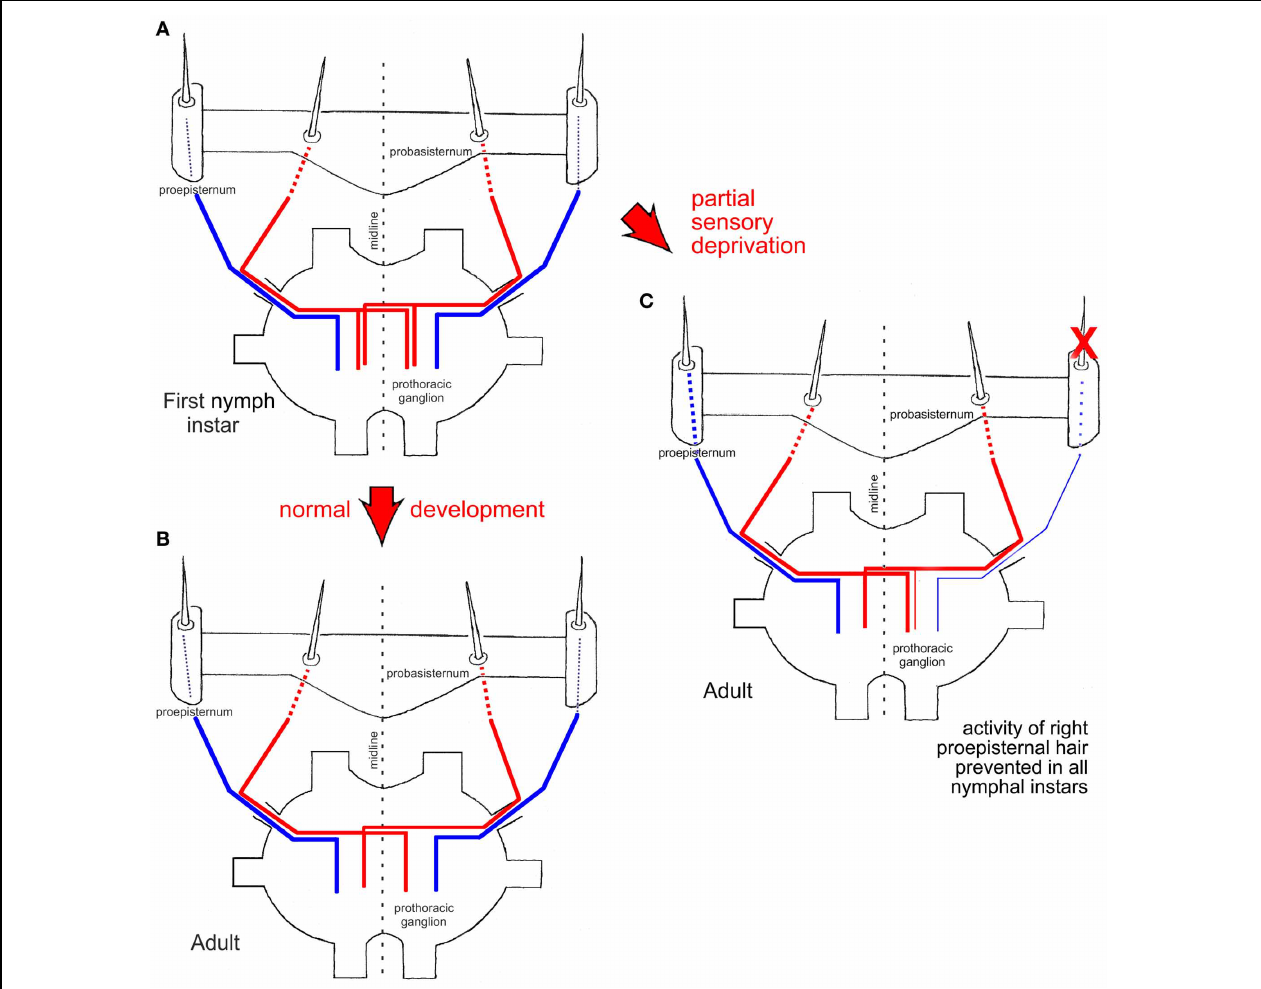
FIGURE 2 | Schematic drawings of central nervous projections of two proepisternal (blue) and two probasisternal (red) filiform hairs into the prothoracic ganglion in a first nymphal instar (A) and an adult (B) (after Pflüger et al., 1994). (C) Experimental adult animal in which the neuronal activity of one proepisternal hair had been prevented in all nymphal instars (red X). Note that the central nervous projection of the experimentally silenced